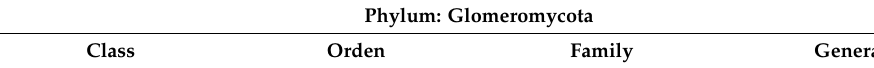
Table A1. Updated taxonomic classification of arbuscular mycorrhizal